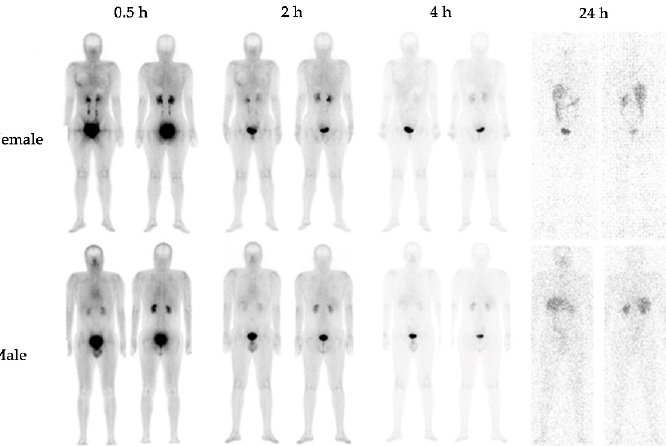
Figure 1. Anterior and posterior planar whole-body images of healthy subjects ( top : female, bottom : male) at 0.5 h, 2 h, 4 h, and 24 h after [ 99m Tc]Tc ‐ iFAP intravenous administration (740 MBq). The [ 99m Tc]Tc ‐ iFAP kinetic model in the blood indicated that the clearance of activity fits a two ‐ component exponential function (Equation (1)) (Figure 2). The first component showed that 70.4% of the radiotracer was removed from the blood with a half ‐ life of 2.22 min (t 1/2 α = ln 2/18.52 = 0.037 h), and 29.6% (second component) was cleared from the blood with a half ‐ life of 90 min (t 1/2 β = ln 2/0.46 = 1.5 h) (Equation (1)). One hour after radi ‐ oligand injection, the percentage of the dose in the kidneys was 7.69 ± 4.80%, and it de ‐ creased to 0.36 ± 0.14% at 24 h. As expected, the highest number of total nuclear transfor ‐ mations occurred in the urinary bladder followed by the kidney and the liver (Table 1). 𝐴(cid:4666)𝑡(cid:4667) (cid:3003)(cid:3039)(cid:3042)(cid:3042)(cid:3031) (cid:3404) 70.40 𝑒 (cid:2879)(cid:2869)(cid:2876) . (cid:2873)(cid:2870)(cid:3047) (cid:3397) 29.60 𝑒 (cid:2879)(cid:2868) . (cid:2872)(cid:2874)(cid:2930) R 2 = 1